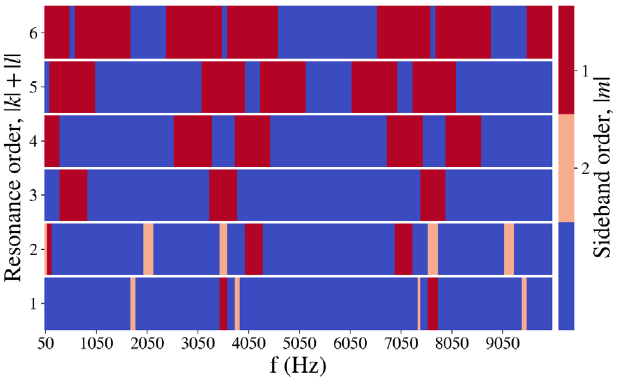
FIG. 11. The modulation frequency as a function of the resonance order N ¼ j k j þ j l j as computed with the visual tool without tracking simulation and for the simulations parameters of Table II. A color code is assigned depending on whether the m ¼ 1 (red) or m ¼ 2 (orange) sideband reaches the footprint or not (blue) for each modulation